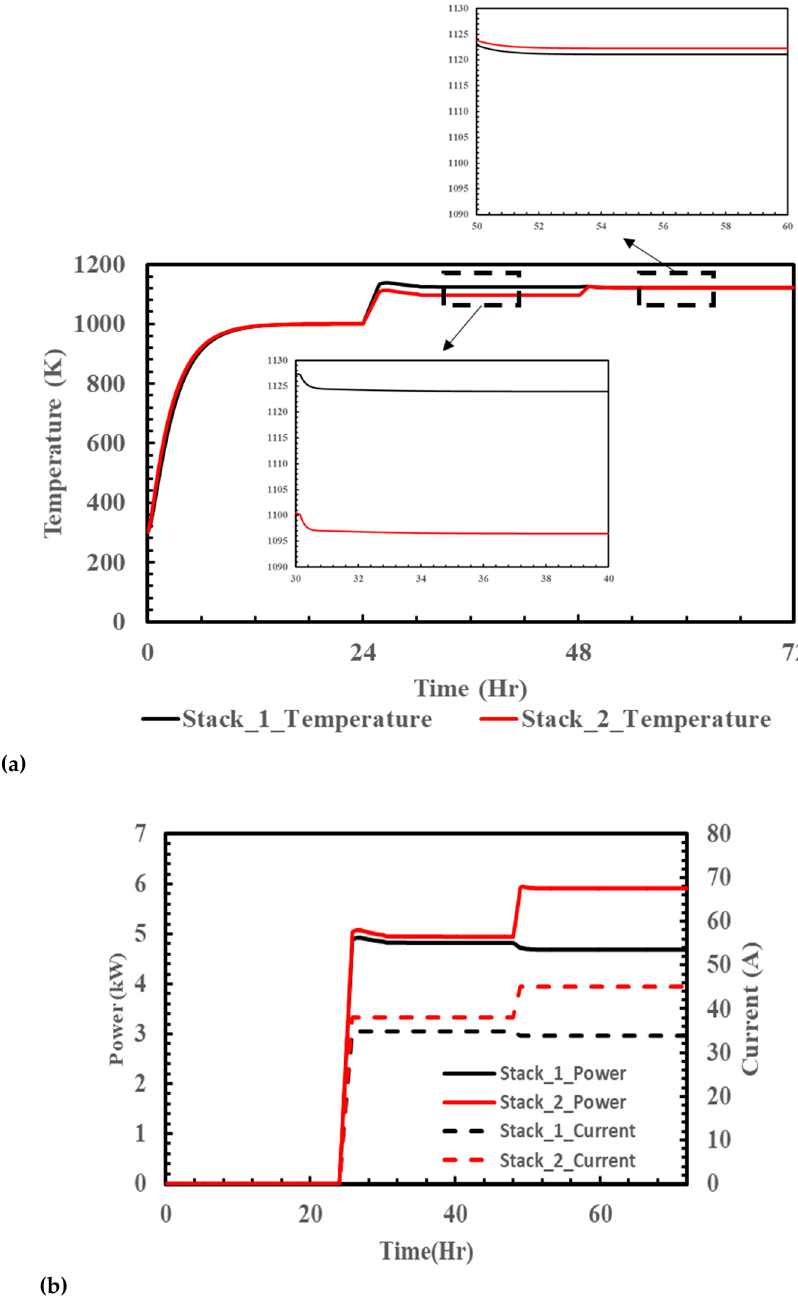
Figure 5. The dynamic curves of ( a ) the stack temperature and ( b ) the operating power and current of the two-stack SOFC system with a non-equal flow split ratio. The inserts show the temperature differences of the two stacks.